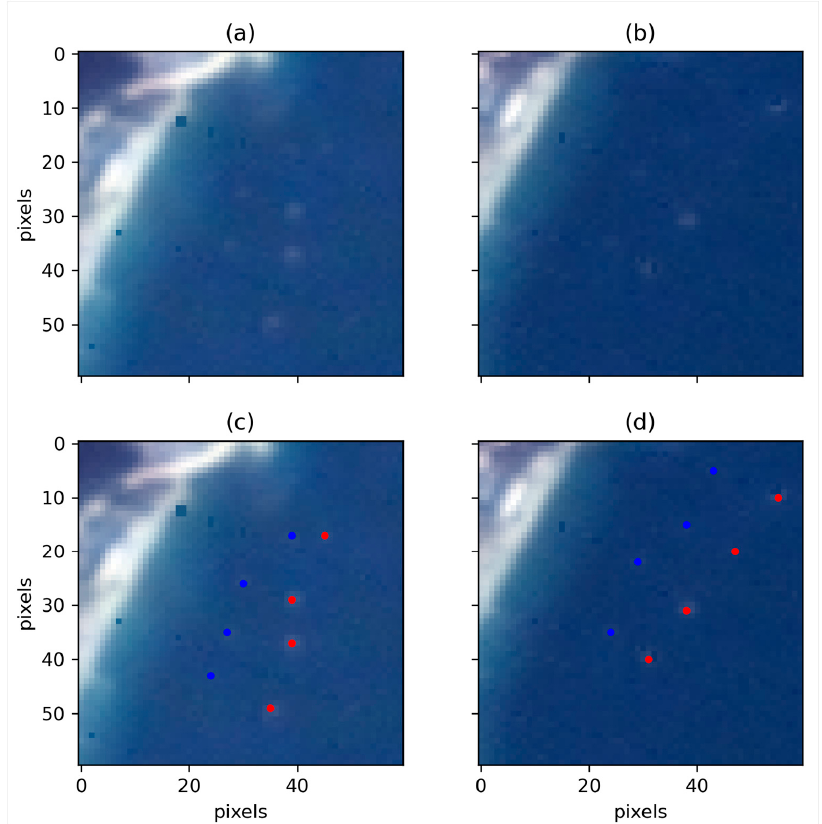
Figure 4. ( a ) Subset of the pan-sharpened PRISMA data acquired on 18 September 2020; ( b ) subset of the pan-sharpened PRISMA data acquired on 22 October; ( c , d ) indicate the positions of the large- and medium-size targets (T-1x in red and T-2x in blue as in Table